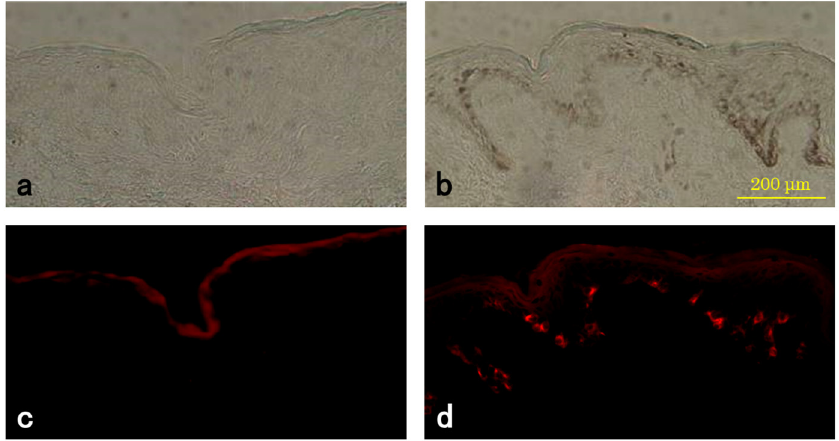
Figure 3. Histochemical measurement of tyrosinase (TYR) activity in SL lesions and perilesional normal skin. Representative sections of perilesional skin ( a , c ) and SL lesional ( b , d ) skin from the same subject (#2) were incubated with tyramide derivatives and photographed under a light microscope ( a , b ) or a fluorescence microscope ( c , d ). TYR-positive cells (stained red) are located on the basal layer. The weak staining of the stratum corneum appeared to be non-specific.